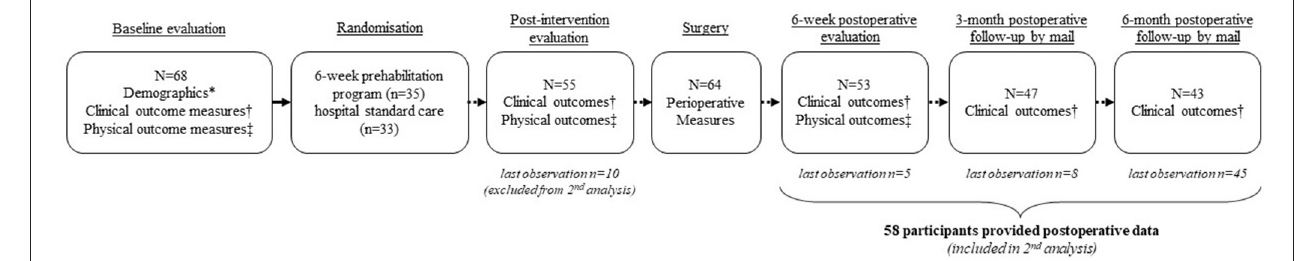
FIGURE 1 | Timeline of outcome assessments and participants flowchart from the original trial. *Demographics included: Age, gender, employment status; variables included in the minimization process (smoking status; disability score ≥ 41%; presence of diabetes; nerve root motor disturbance confirmed by electrodiagnostic test); number of months since pain first started; presence of comorbidities; previous use of conservative care. †Clinical outcome measures included: Leg pain and low back pain intensity (Numerical Rating Scale); pain dominance (leg or back); low back pain-related disability (Oswestry Disability Index); Quality of life (European Quality of life EQ-5D); Kinesiophobia (Tampa scale of kinesiophobia); Depression (Beck Disability Index); Patients’ global impression of change (at the post intervention assessment only). ‡Physical outcome measures included: Active lumbar ranges of motion; Lumbar flexor and extensor muscles maximum isometric voluntary contraction;